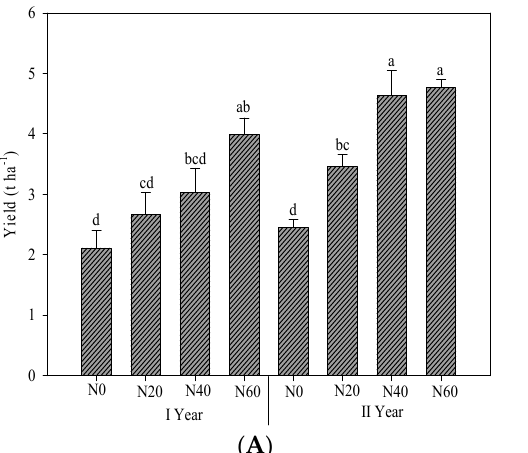
Figure 3. Culms, leaves and spikes percentage of barley as affected by growing season (2018–2019 = I Year; 2019–2020 = II Year). Different letters indicate significant differences according to Duncan’s test ( p < 0.05). ns = non-significant.